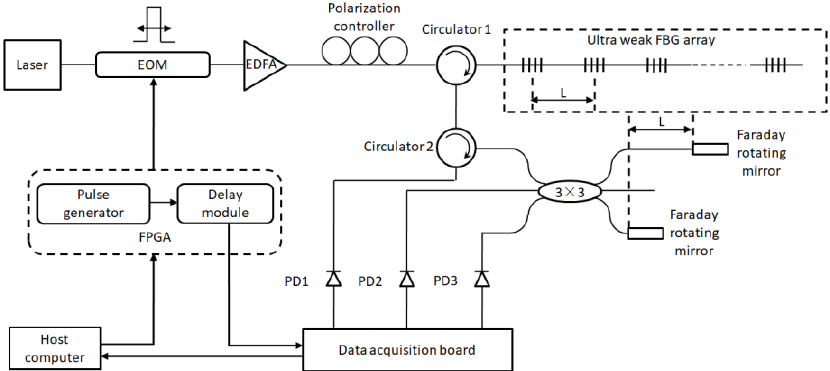
Figure 1. Sensing principle of distributed vibration detection based on ultra-weak FBG